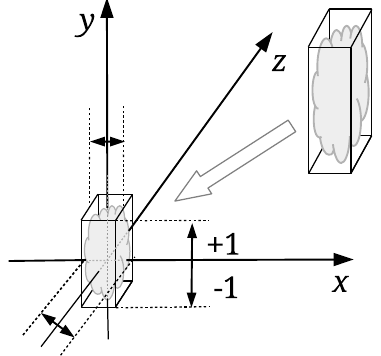
Figure 2. Normalization of input point